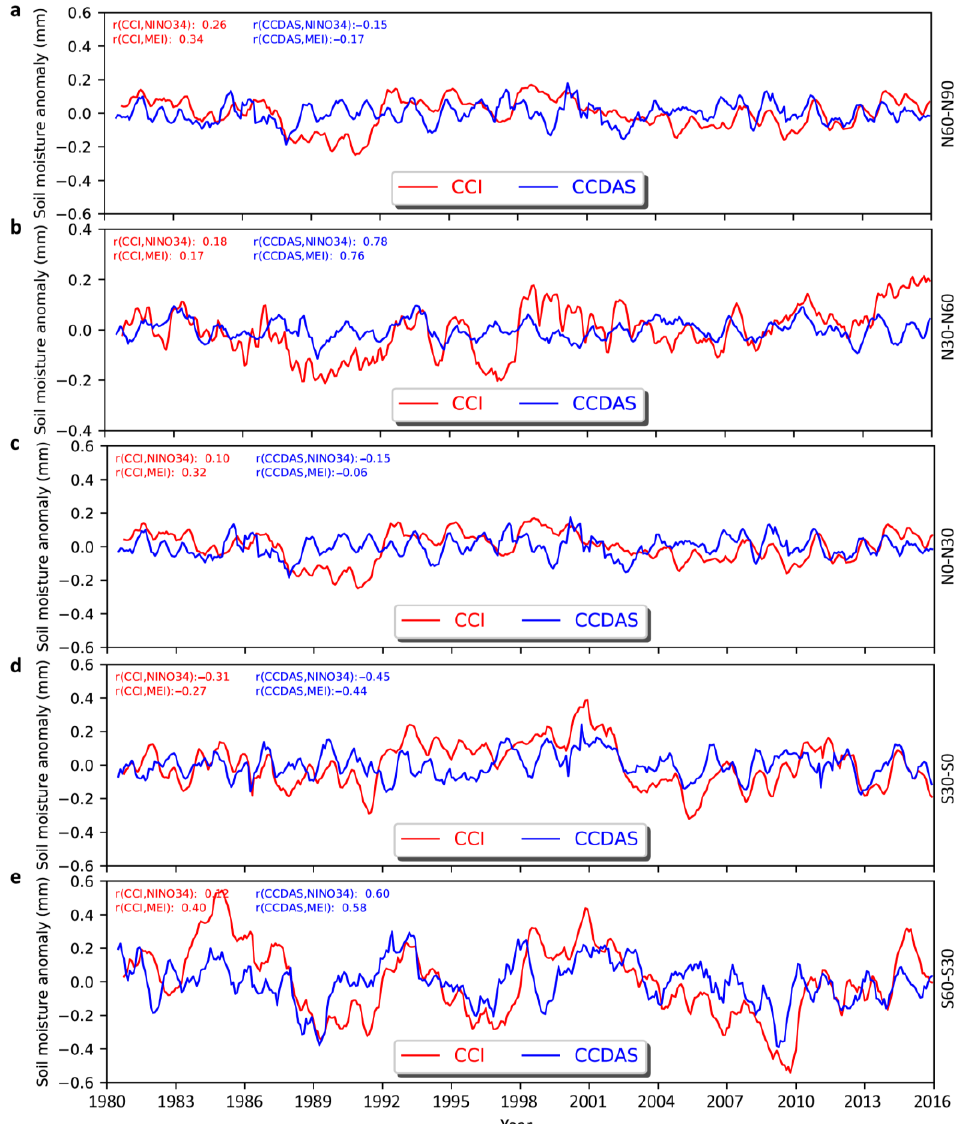
Figure A2. Time series anomalies of soil moisture from ESA-CCI and from CCDAS optimization ( ‘ sm+co 2 ’ ) at various latitudes. ( a – e ) denotes different latitude. The anomalies are calculated from the mean surface soil moisture for each latitudinal band. Red lines for CCI and blue lines for CCDAS (‘sm+co 2 ’ ). The correlations of soil moisture anomalies and two ENSO indices (MEI and Niño 3.4) are depicted in each figure.